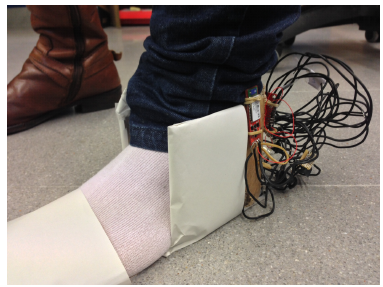
Figure 19. User wearing the